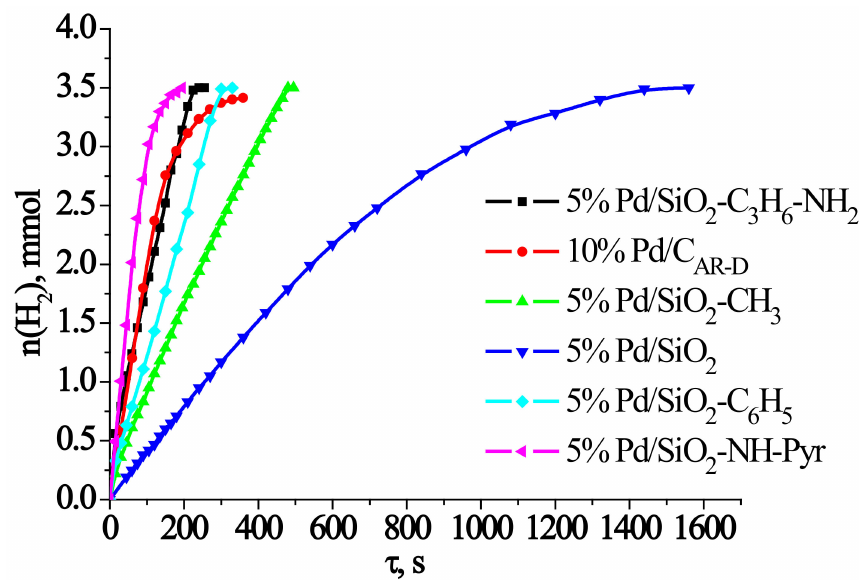
Figure 10. Kinetic curves of hydrogen uptake in liquid-phase hydrogenation of sodium maleate in water. T = 298 K, m (cat) = 0.3 ± 0.05 g, C (SM) = 0.18 M, V (SM) = 20